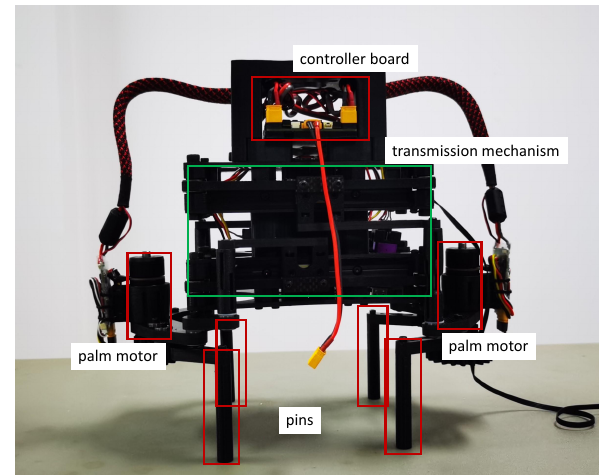
Figure 1. Illustration of the four-pin